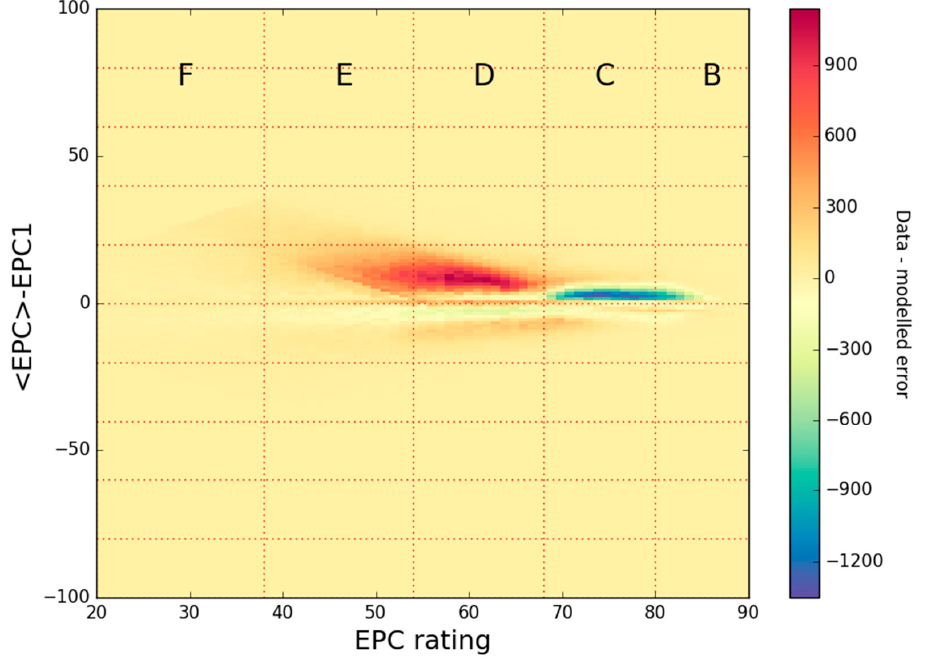
simply measuring and inputting data. This is reflected upon in the Discussion.